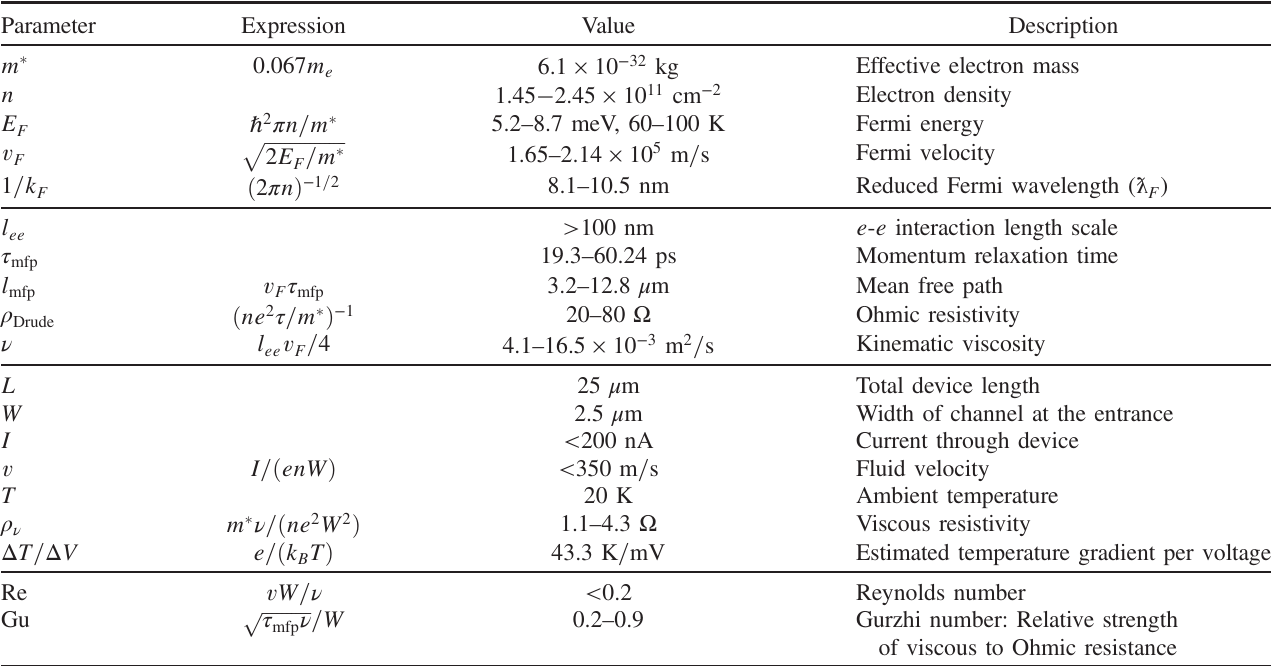
ffiffiffiffiffiffiffiffiffiffi p ντ =W mfp